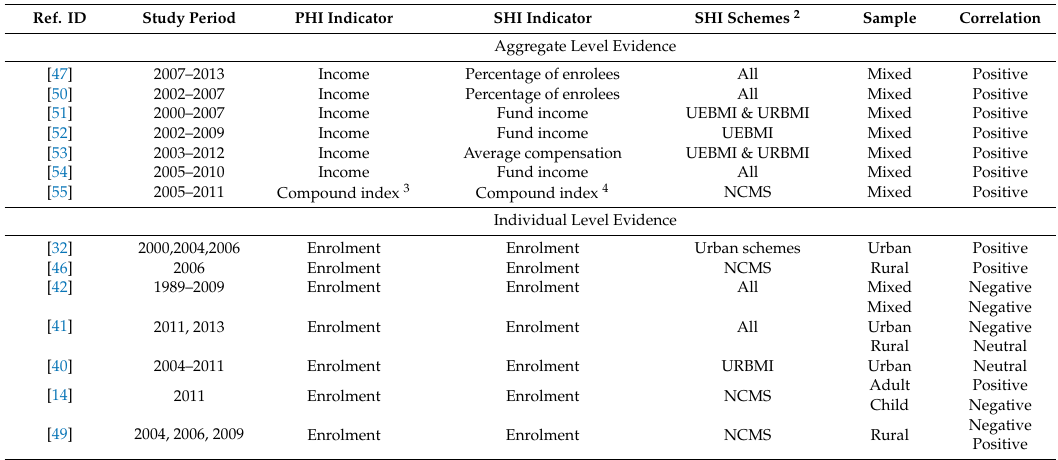
Table 3. Relationship between PHI prevalence and social health insurance(SHI) system expansion 1 . Ref.